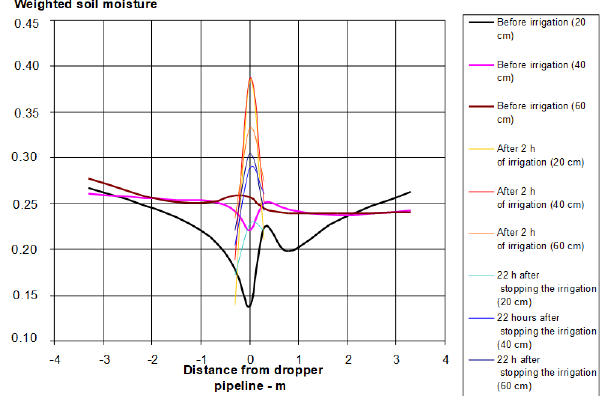
Figure 10. Weighted soil moisture at different distances from the dripper pipeline around the first tensiometer